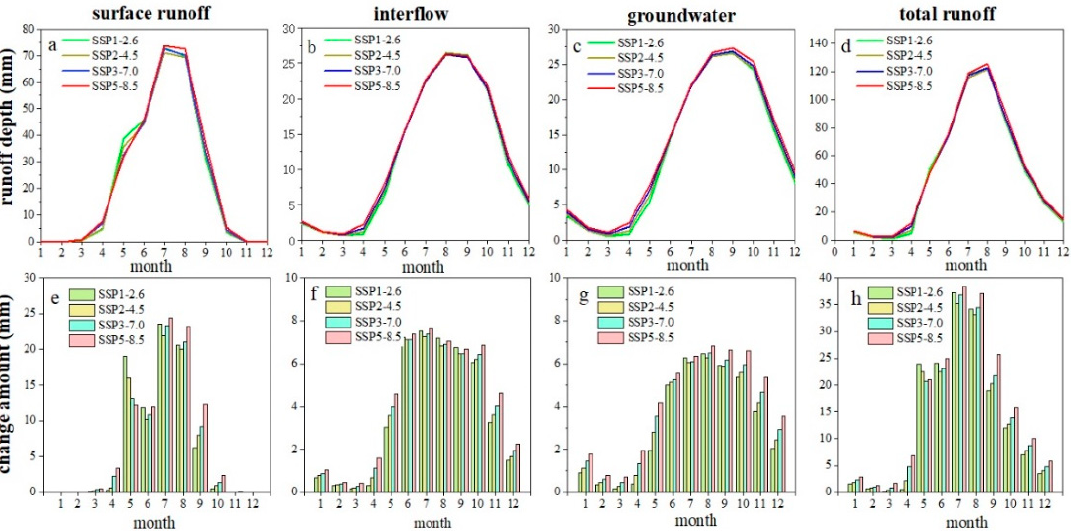
Figure 8. Monthly ( a ) surface runoff depth; ( b ) interflow depth; ( c ) groundwater depth; and ( d ) total runoff depth for 2020–2100. Monthly ( e ) surface runoff depth variation; ( f ) interflow depth variation; ( g ) groundwater depth variation; and ( h ) total runoff depth compared to the baseline period of 1983–2017 in the study area under the four scenarios.